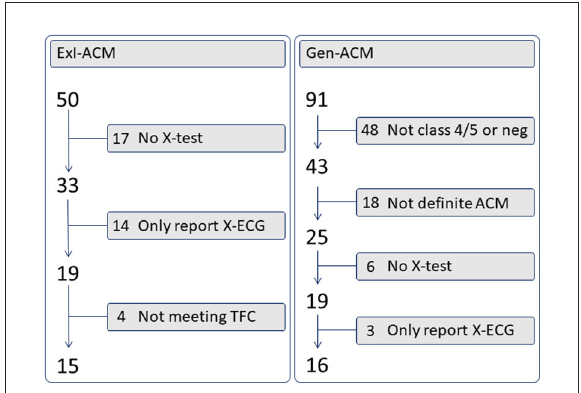
FIGURE1 Recruitment flowchart ACM patients. No X-test, no exercise test was found in the medical record; Only report X-ECG, an exercise test had been performed, but the tracings could not be retrieved from the medical record; Not class 4/5 or neg, no class 4 or 5 genetic mutation was found (i.e., class 3 or lower, or none); Not meeting TFC, not meeting the 2010 Task Force Criteria as defined in the methods